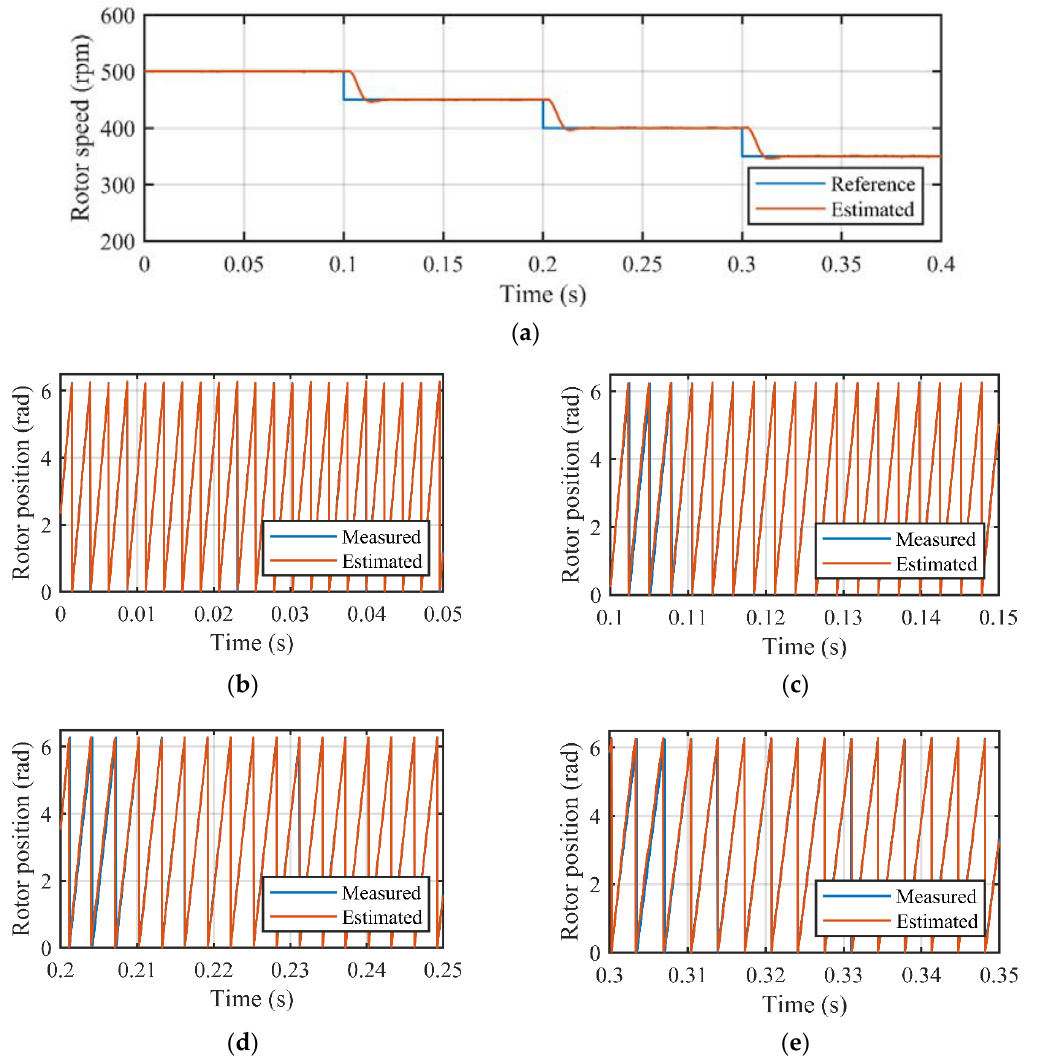
Figure 14. Experimental results of reference speed multi-step changes strategy, from 500 to 350 rpm, for ( a ) rotor mechanical speed response and rotor electrical position responses at ( b ) 500, ( c ) 450, ( d ) 400, and ( e ) 350 rpm.